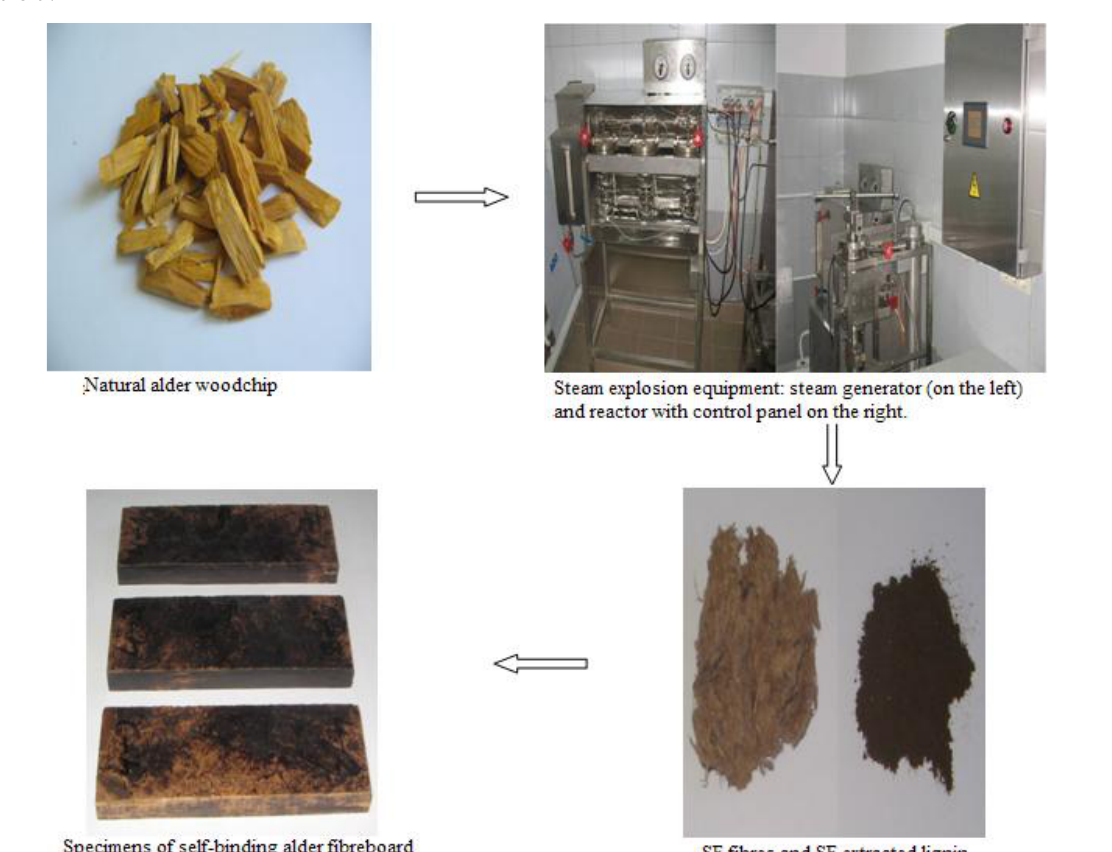
Fig. 7. An illustrative display of processing the hot-pressed boards Table 6. Properties of hot-pressed sample boards. ± – standard deviation